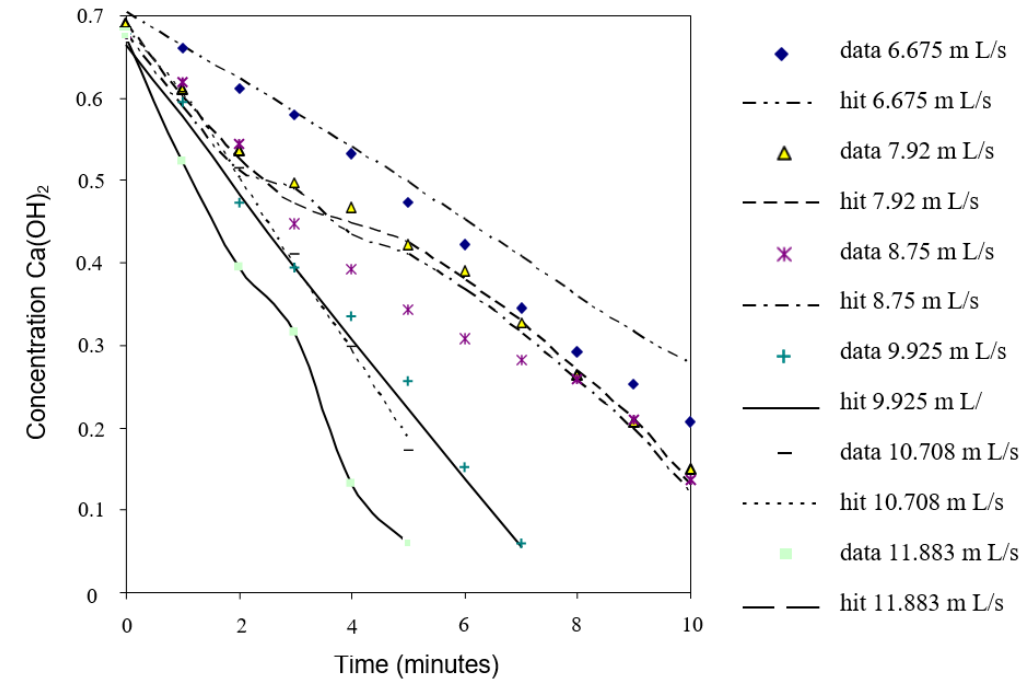
Figure 4. The relationship between the concentration of Ca(OH) 2 in mgmol/cm 3 with time at various gas flow